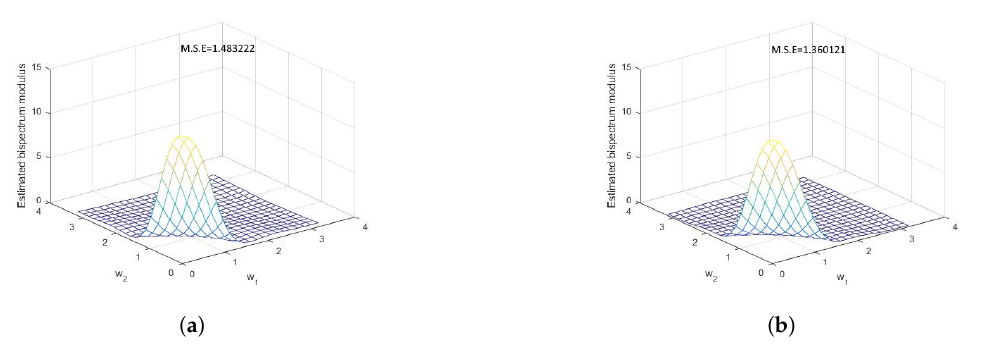
Figure 13. The estimated bispectrum modulus using Tukey–Hamming window. ( a ) Generated observations. ( b ) Forecasted